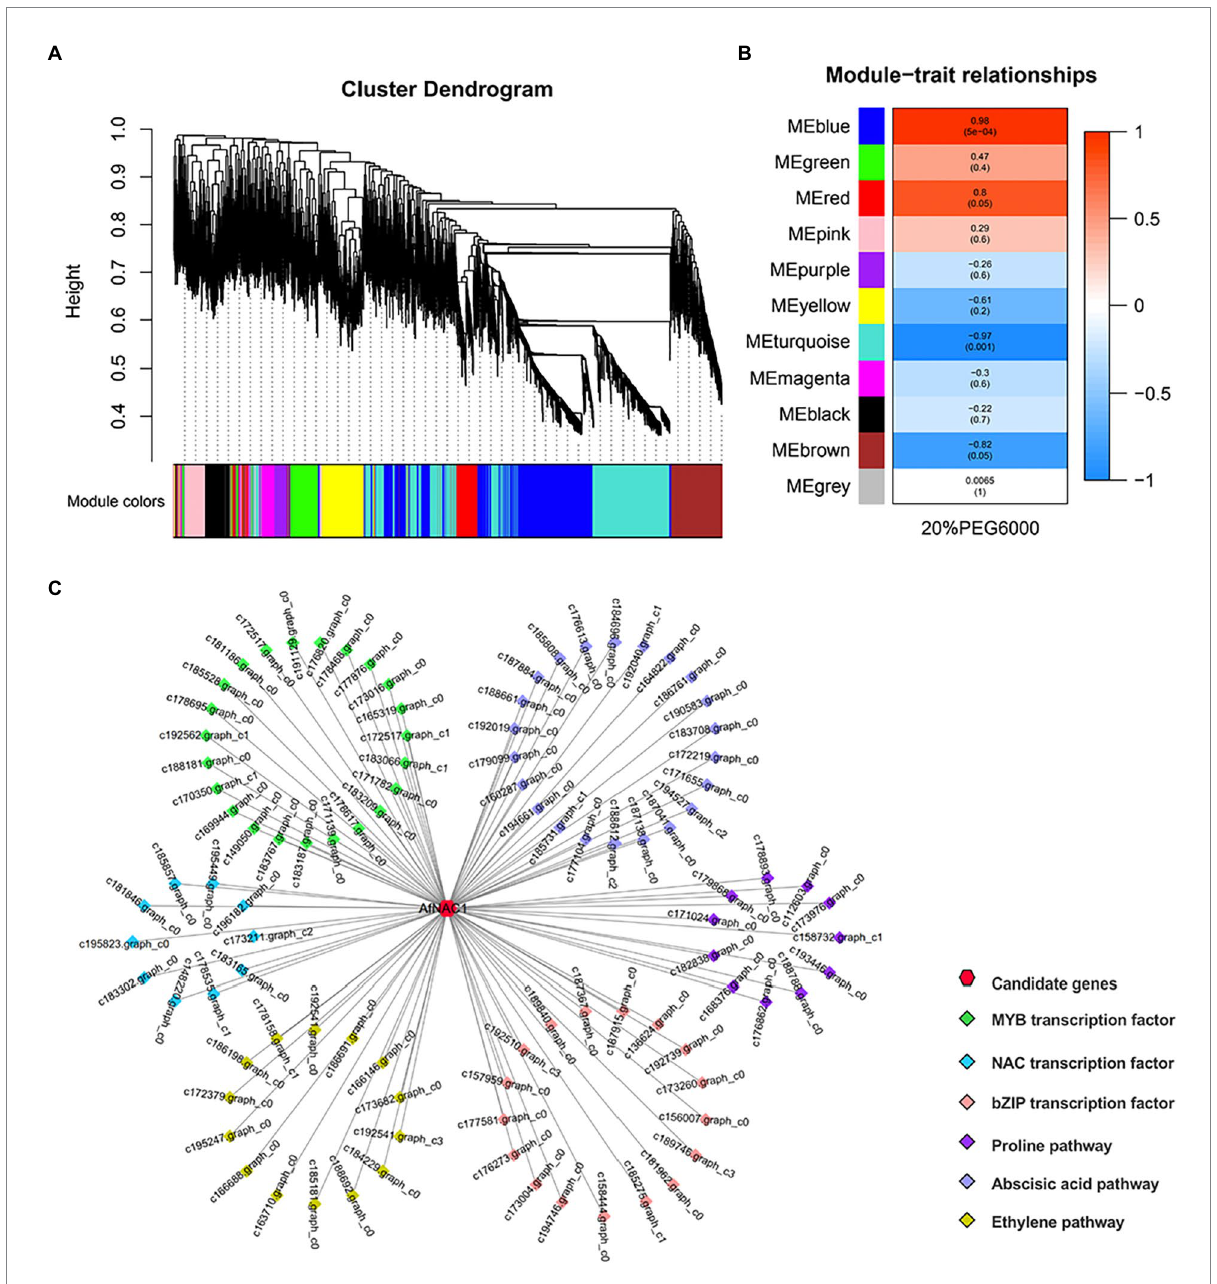
FIGURE 1 Results of gene co-expression analysis. (A) Gene clustering map. The different colors indicate the constructed vector complex modules, the phylogenetic tree indicates the hierarchical clustering of different samples, and each sample corresponds to one color of the corresponding module (B) Heat map of co-expression module associated with 20% PEG6000. (C) Correlation analysis between